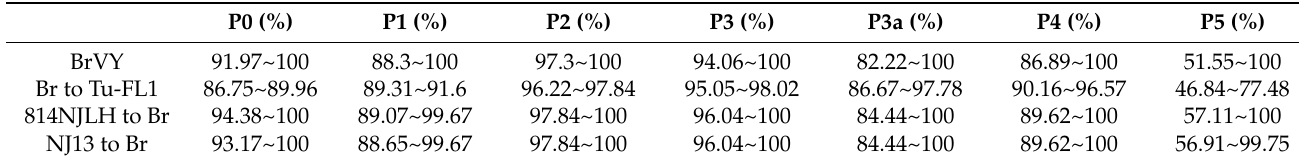
Table 2. Pairwise amino acid identity of BrYV and TuYV coding